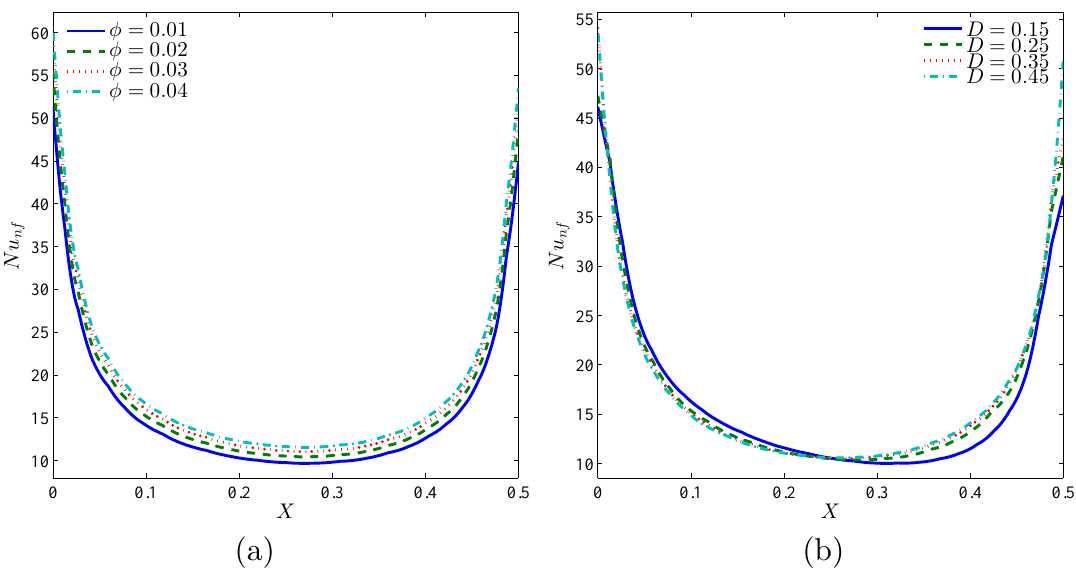
Figure 11. Plots of the local Nusselt number vs. X for different ( a ) φ and ( b ) D at Ri = 10 and Ha =